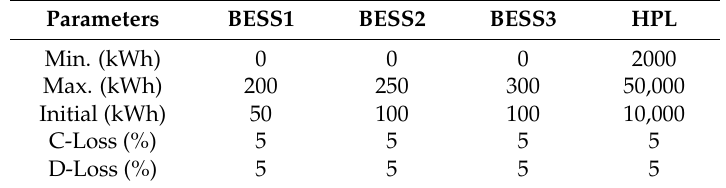
Figure 6. Load profiles and output power of RDG in each building during a weekend day. Table 2. Parameter of BESSs and HPL